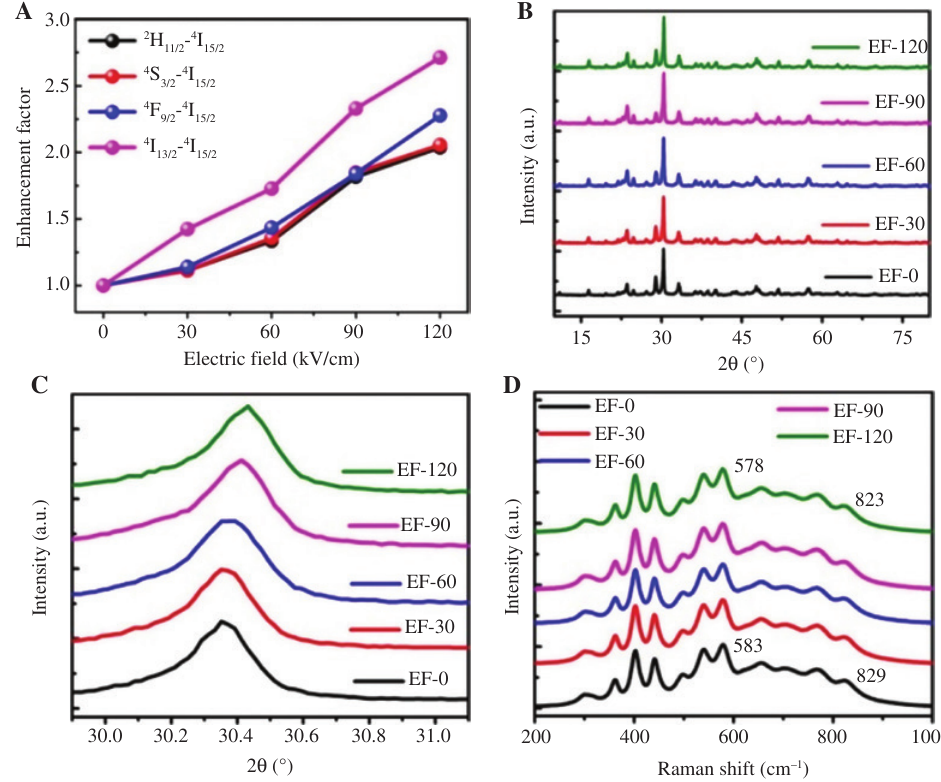
Figure 4: The enhancement of the emission factor, and the change in crystal structural characteristics after the polarization engineering. (A) The relationship between the enhancement factor and the electric field intensity. (B) The XRD patterns of the prepared samples after loading different electric fields. (C) Partially amplified XRD patterns of the prepared samples after loading different electric fields. (D) The Raman spectra of the prepared samples after loading different electric fields.